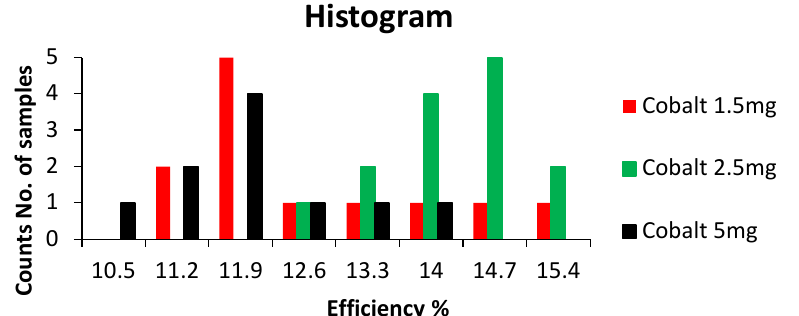
Figure 15. Energy gap of M-TiO 2 doped with various concentrations of FK209 (1.5 mg, 2.5 mg and 5 mg) using Tauc plot. Dotted lines represent the tangent to the slope for each plot.